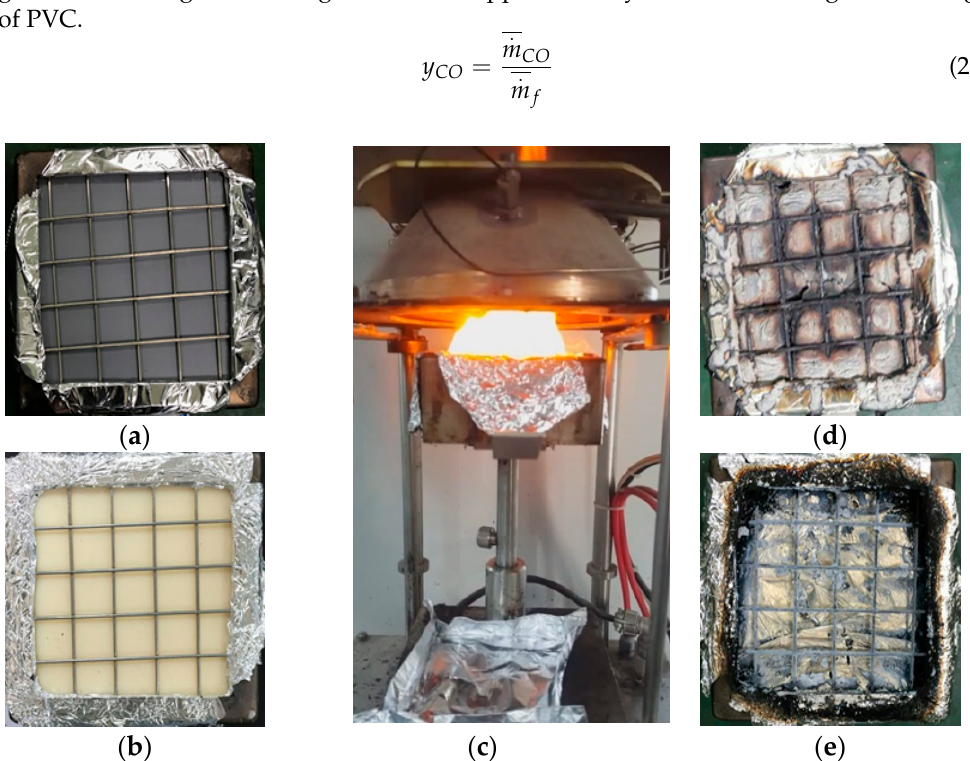
Figure 1. Burning experiments of ABS and PVC with ISO 5660-1 cone calorimeter: ( a ) PVC before experiment; ( b ) ABS before experiment; ( c ) Cone calorimeter experiment; ( d ) PVC after experiment; ( e ) ABS after